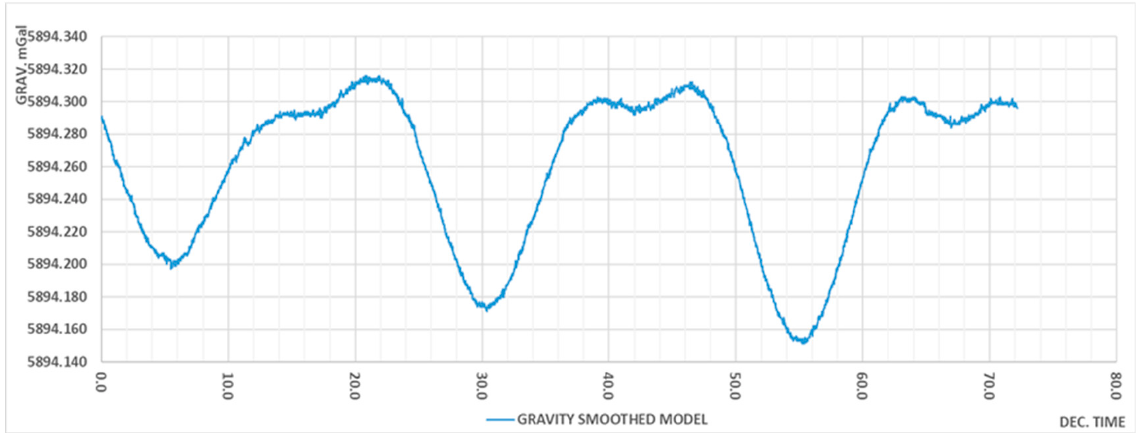
Figure 2. Smoothed gravity model (original figure).